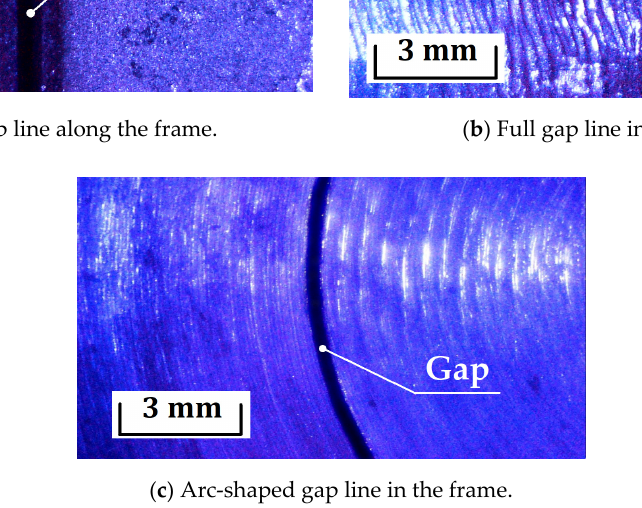
Figure 11. Images of gap lines between welded workpieces with the LRC-W complex obtained from a CCD camera of HD resolution.